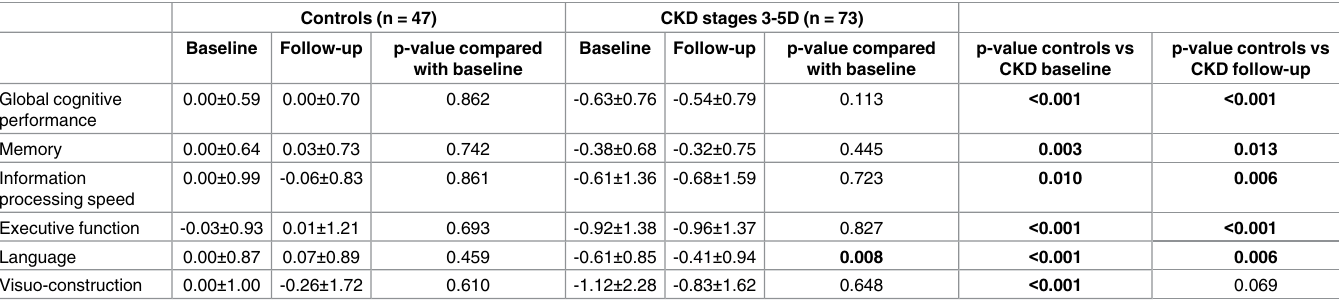
Table 3. z-values of Global Cognition and Cognitive Domains in Controls and CKD patients at Baseline and Follow-up. Controls (n = 47) CKD stages 3-5D (n = 73) Baseline Follow-up p-value compared Baseline Follow-up p-value compared p-value controls vs p-value controls vs with baseline with baseline CKD baseline CKD follow-up Global cognitive < performance